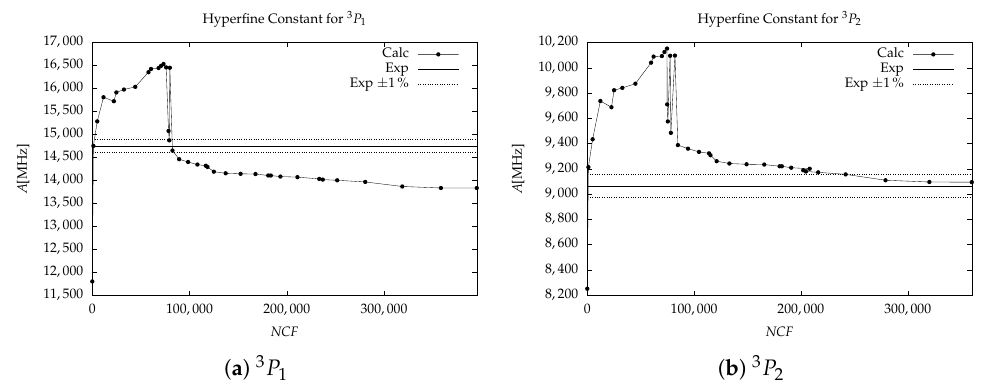
Figure 2. Calculated values of the hyperfine constant A with increasing CSF expansions. The horizontal lines show the experimental values ±